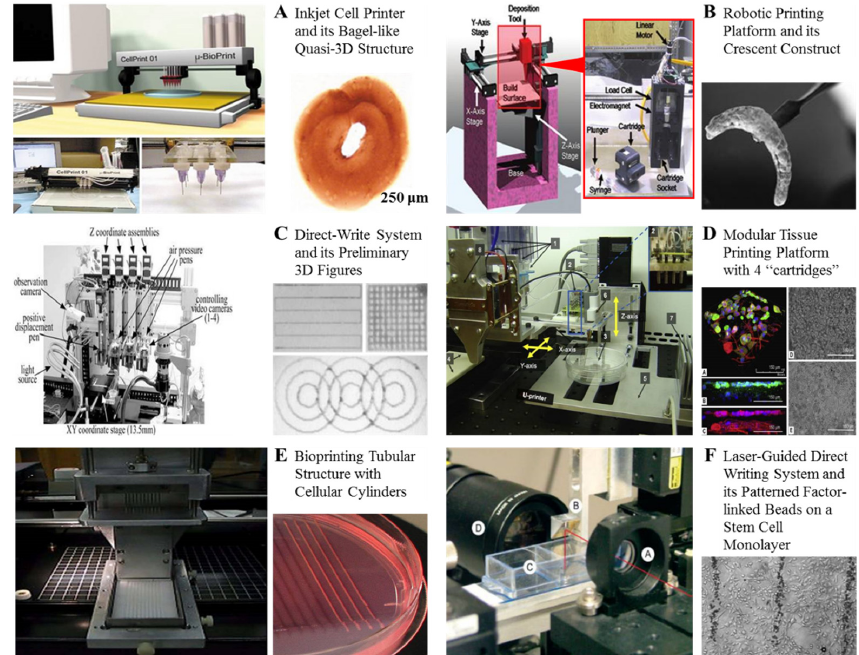
Figure 1. ( A ) A inkjet cell printer and its bagel-like quasi-3D structure [9]; ( B ) A robotic